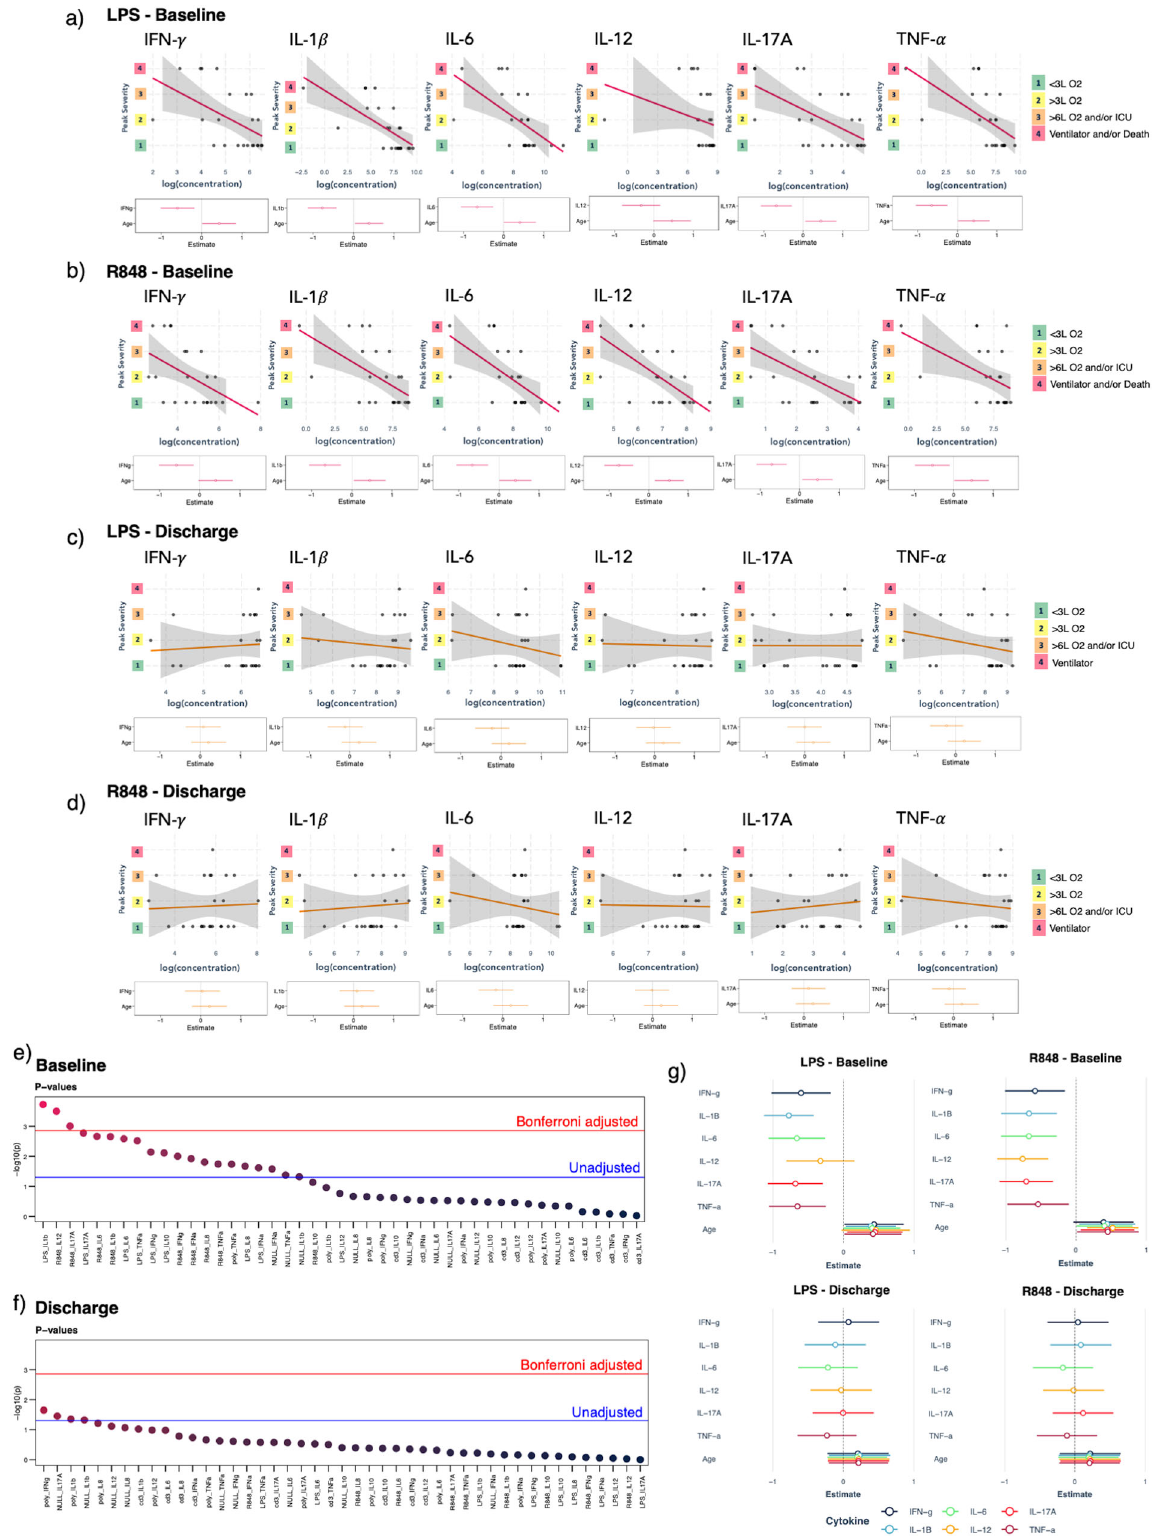
Associations between stimulated cytokine responses and peak disease severity . To further understand the clinical utility of this data and methodology, we investigated associations between cytokine stimulus-response (CSR) variables and peak disease severity across three clinical use-cases by ordinary least squares (OLS) (Fig. 4, Supplementary Figs. 5 – 7 and Supplementary COMMUNICATIONS MEDICINE| (2022) 2:114